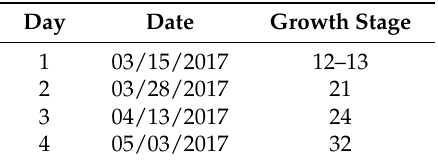
Table 1. Sampling dates and growth